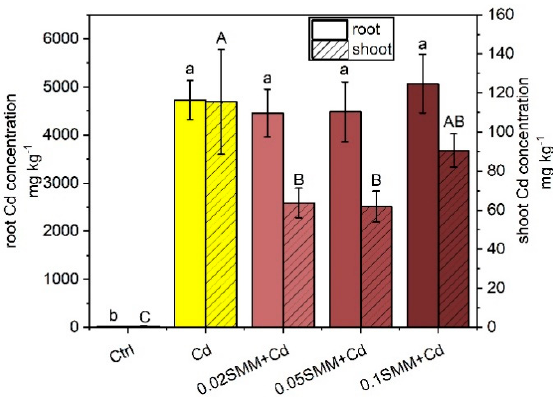
8 of 20 Figure 3. Photochemical reflectance index (PRI) ( A ), maximal quantum efficiency of PSII reaction